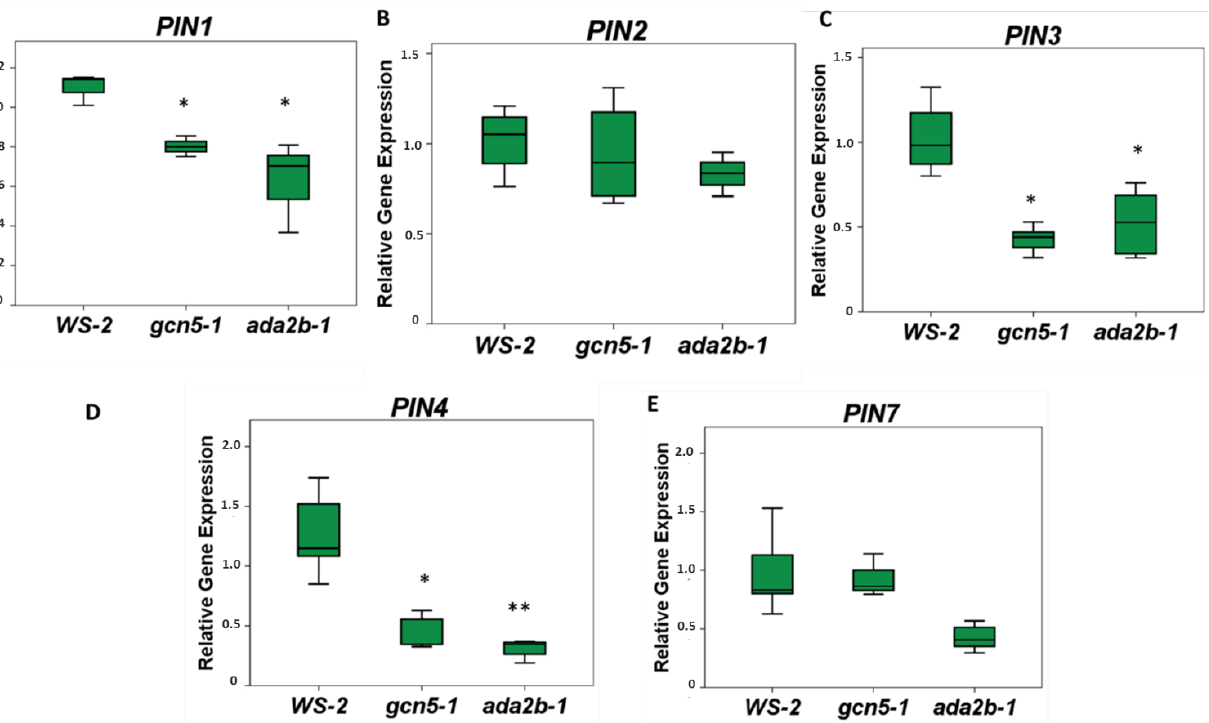
Figure 3. The role of GCN5 and ADA2b in PIN gene expression in Arabidopsis thaliana roots. The roots of seven-day-old Ws-2, gcn5-1 , and ada2b-1 seedlings were harvested for qRT-PCR analysis for the genes (A) PIN1 , (B) PIN2 , (C) PIN3 , (D) PIN4 , and (E) PIN7 . The bars represent the range of the two quadrants. The horizontal line in the bar is the median, while the terminals are the minimum and maximum values of the data. Asterisks indicate the statistical significance based on an independent samples t -test: * p < 0.05, and ** p < 0.01.